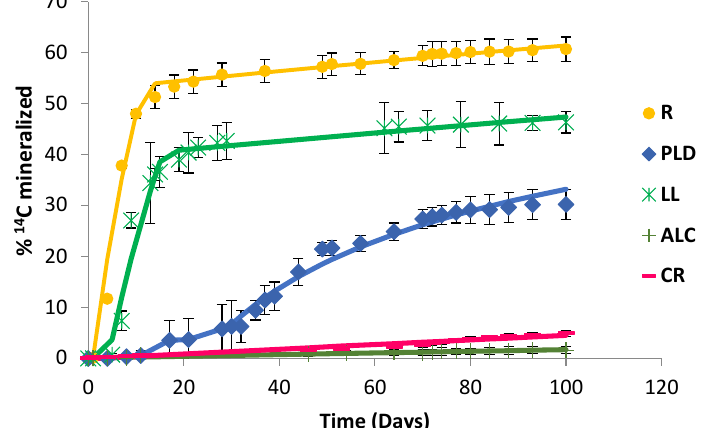
Figure 1. Chlorpyrifos mineralisation curves (100 d) in R, PLD, LL, ALC, and CR soils.